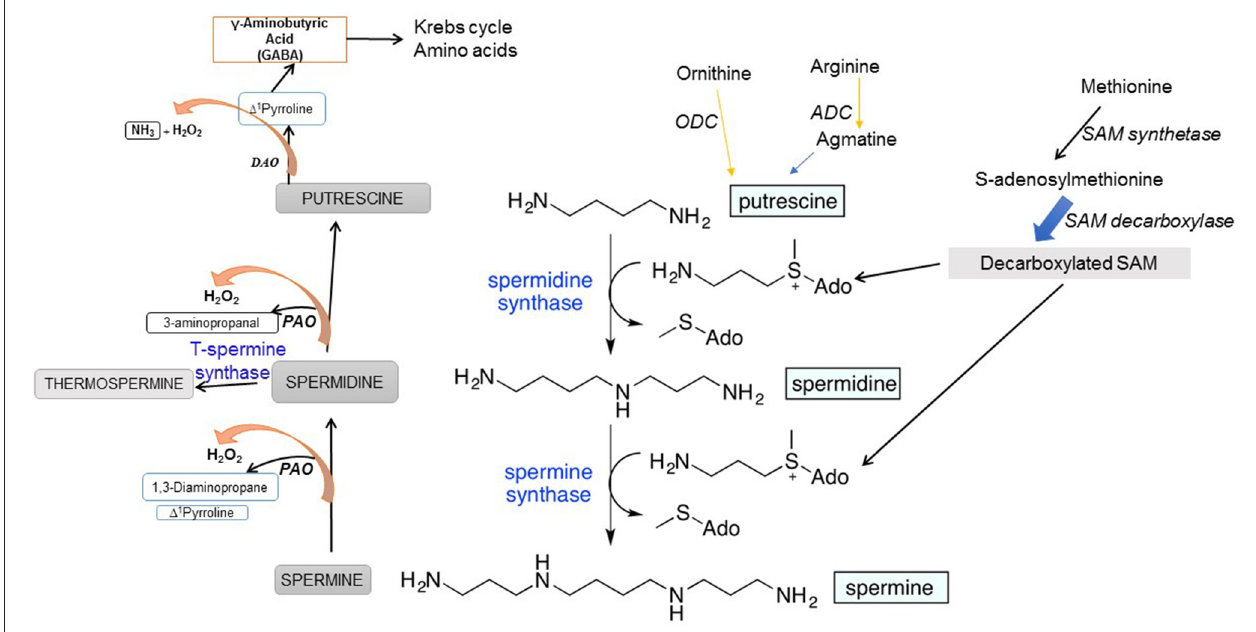
FIGURE 1 | Polyamine biosynthetic and the back-conversion pathways in plants.